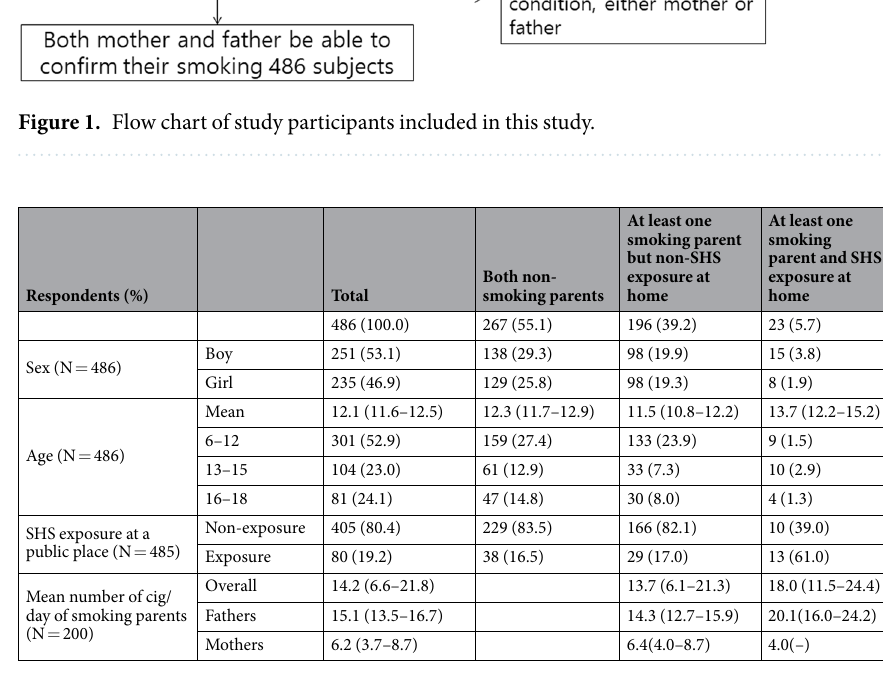
Table 1. Characteristics of parental smoking patterns (number of respondents, weighted percentages). All percentages are